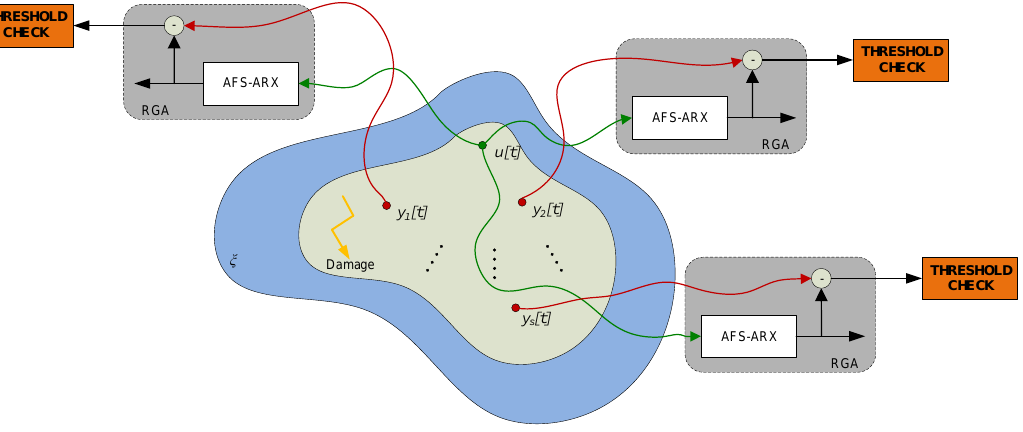
Figure 1. Layout of the residual generation algorithms for damage